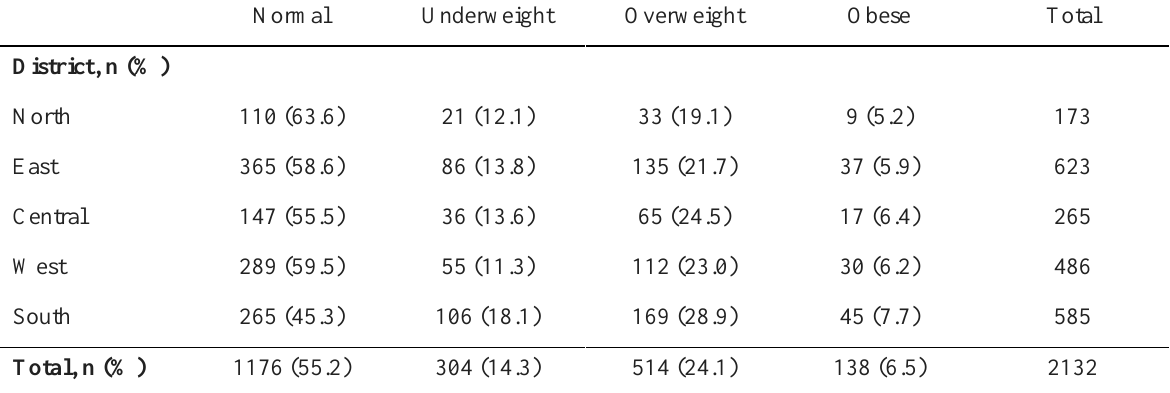
Table 2 . Prevalence of overweight and obesity in female adolescents in the South District (18.1%) and was lowest in the West District